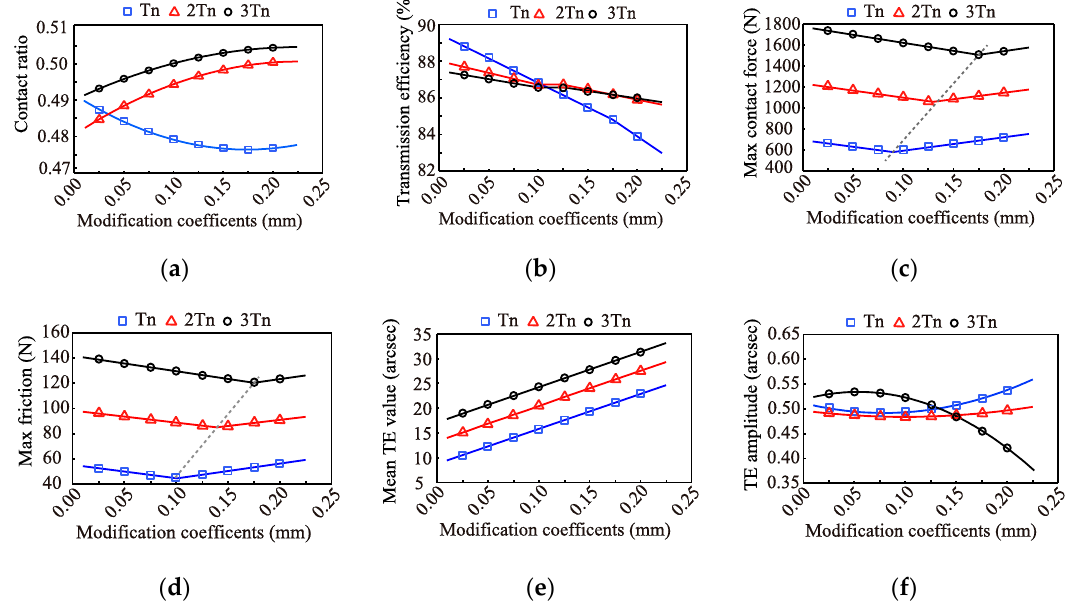
Figure 13. Effect of case 2 modification method on the transmission performance of RV reducer: ( a ) contact ratio, ( b ) transmission efficiency, ( c ) max contact force, ( d ) max friction, ( e ) mean TE value, and ( f ) TE amplitude.